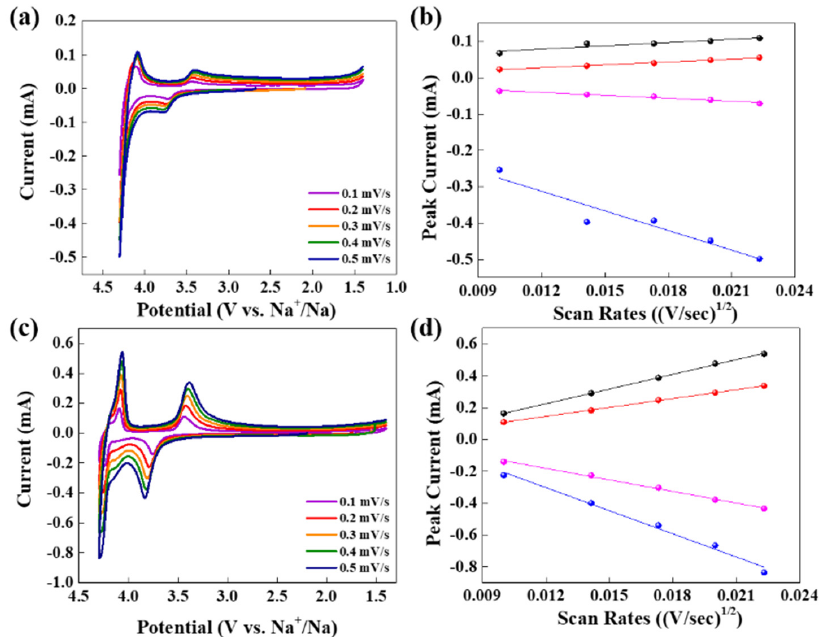
Figure 7. Cyclic voltammetry profiles of ( a ) NMCP and ( c ) NMCP/rGO at 0.1 mV/s to 0.5 mV/s, and the relationship between the peak currents and the square root of the scan rates of ( b ) NMCP and ( d ) NMCP/rGO.